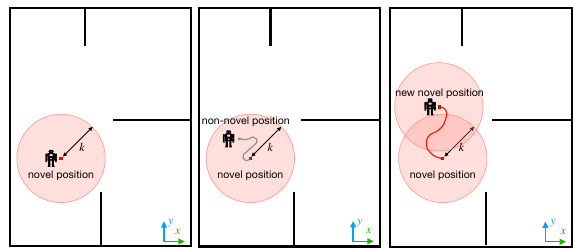
Figure 2. Intuitive representation of the novelty circle with radius k